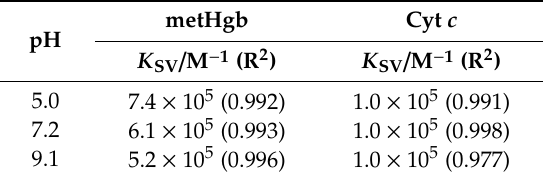
Table 1. Sensory e ffi ciencies of C-dots toward metHgb and Cyt c at various